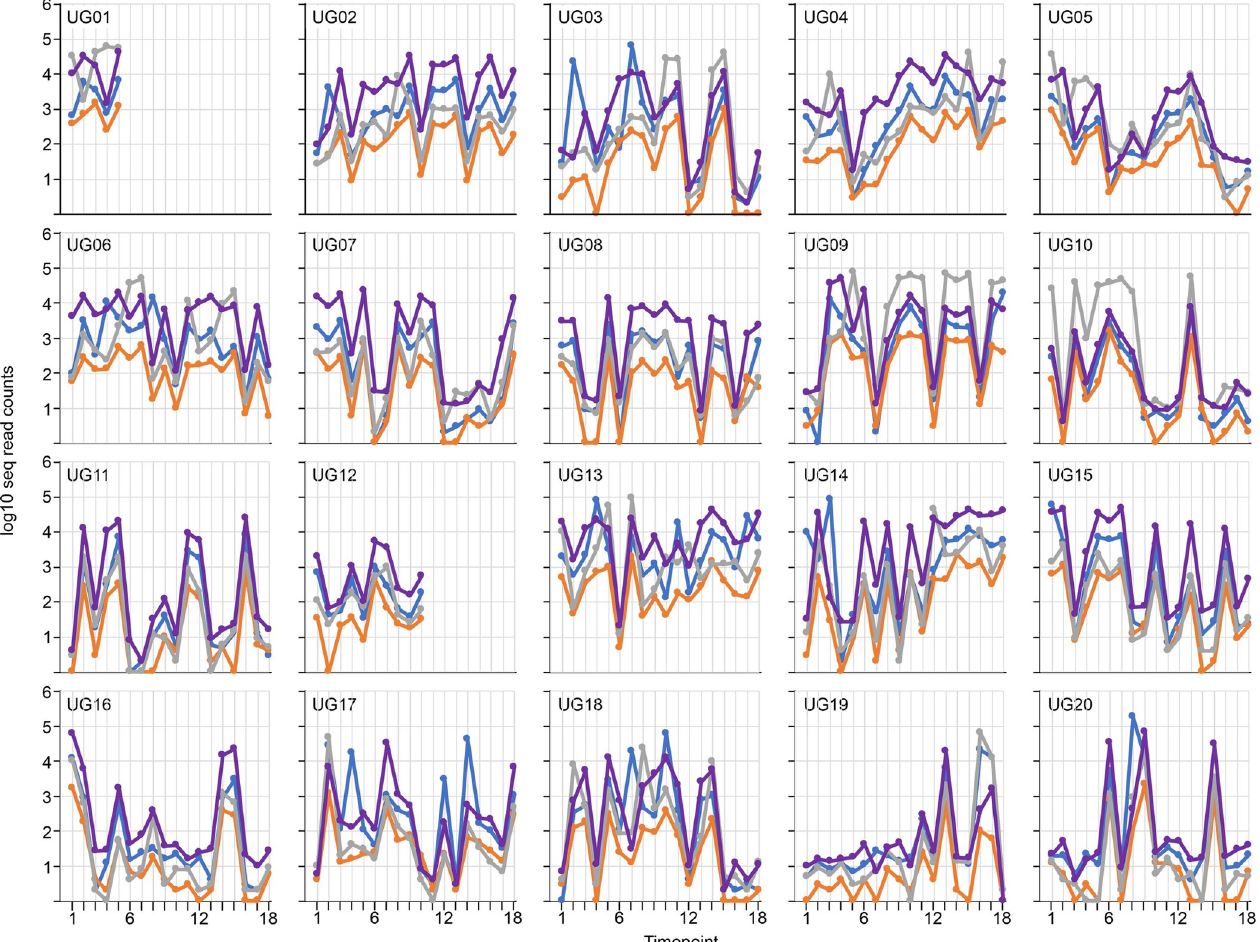
Fig 5. Infections of individual cattle with the different species of trypanosome over two years in Accra. The colour code for each species is indicated: blue, T . brucei ; orange, T . congolense ; grey, T . theileri ; purple, T . vivax . The y-axis is a logarithmic scale.